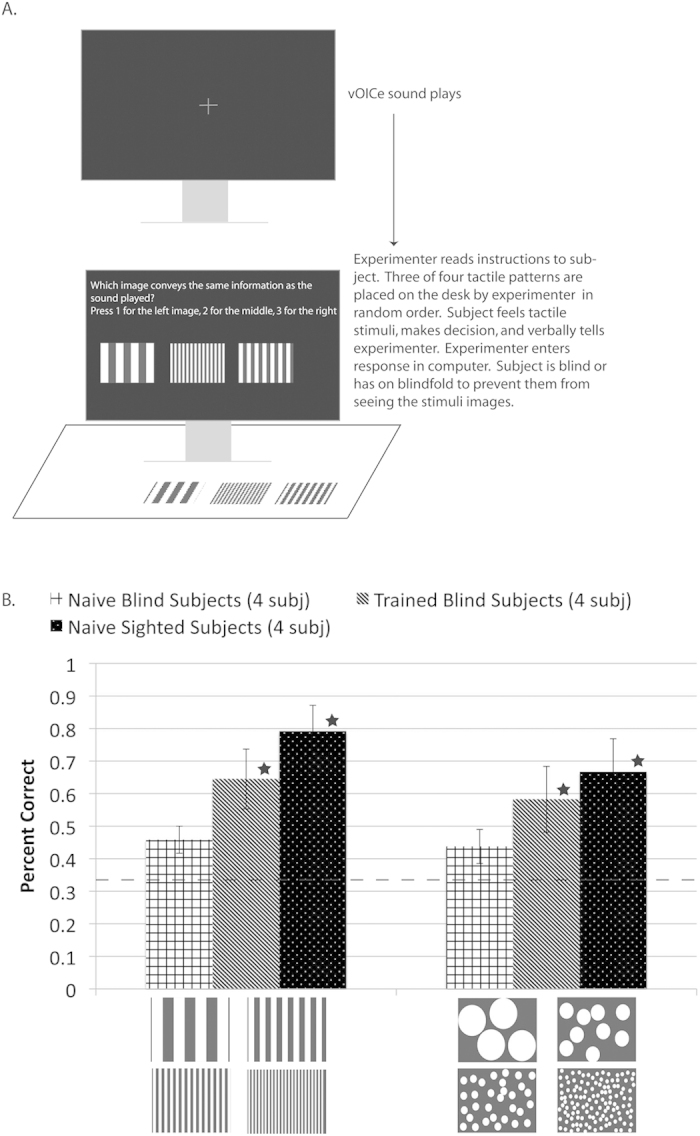
Data and images from matching vOICe sounds and tactile patterns tested on both naive and trained participants.(a) Is a diagram of the experiment where blind and sighted participants (sighted participants wore blindfolds) were tested at matching a vOICe sound to one corresponding tactile pattern out of three presented (the white regions of the tactile patterns are raised relative to the black regions). The data for the experiment is presented in (b). The grid bars represent naive blind, the gray bars (fine diagonal pattern) represent trained blind, and the black bars (white polka dot) represent naive sighted subjects. The error bars represent the standard deviation across participants and the dashed line represents chance for (b). In addition, stars indicate that the subjects performed significantly better than chance (p < 0.004, with Bonferroni correction). It is useful to note that the blind subjects were tested naively, then trained and tested again post-training, therefore total subjects is N = 4 (this method was required because of the difficulty of recruiting blind participants) (Table S2)). Schematic and Image generated by N. Stiles.